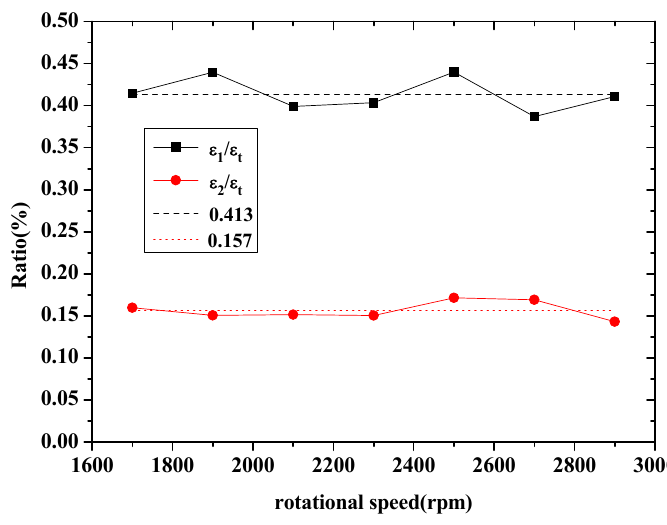
Figure 6. The acoustic energy changing curves with rotational speed.